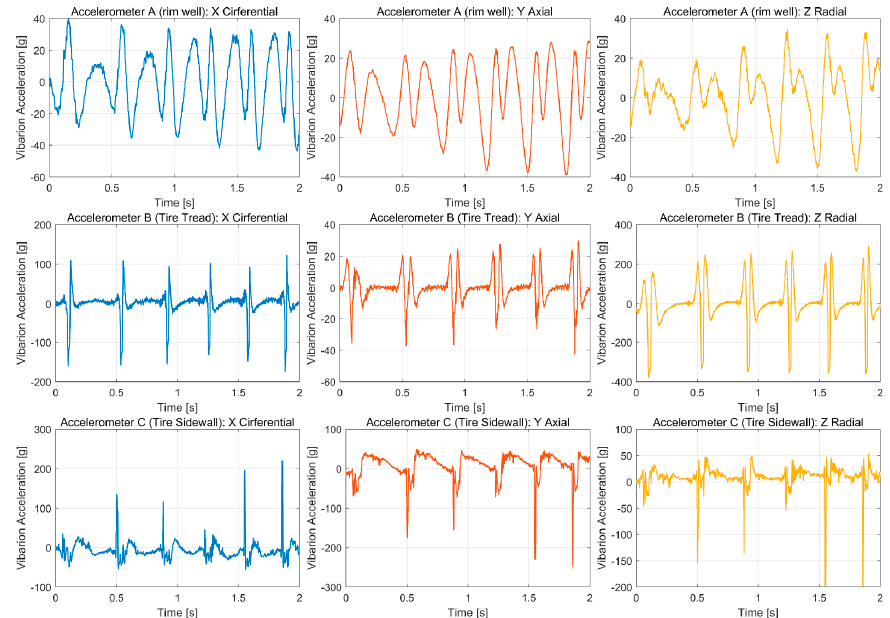
Figure 4. Vibration acceleration of rim well, tire tread, and sidewall in three directions.